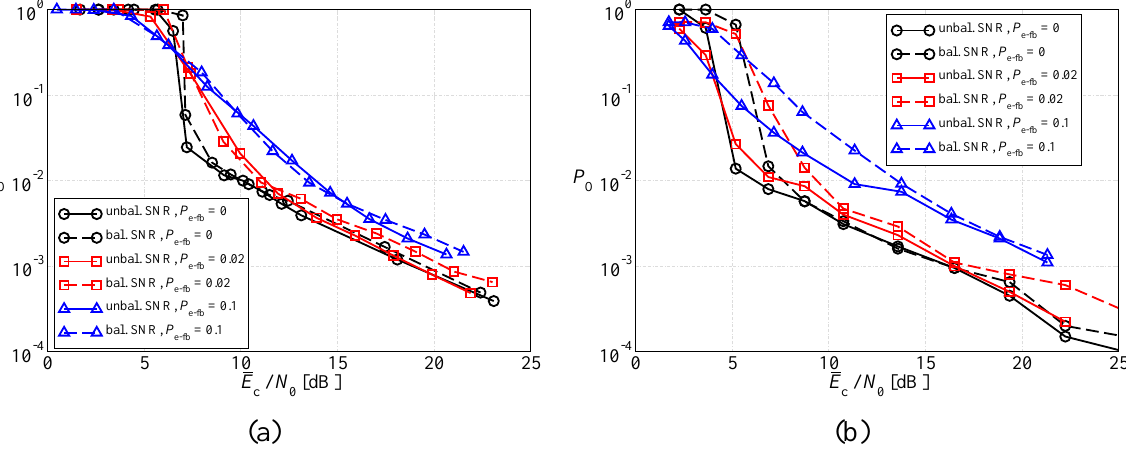
Figure 12. Outage probability, as a function of the average SNR at the sources, in a scenario with noisy feedback channels, considering: (a) DD LDPC-coded schemes and (b) SCCCed schemes. Two possible values for P are considered: (i) 0.02 and (ii) e − fb